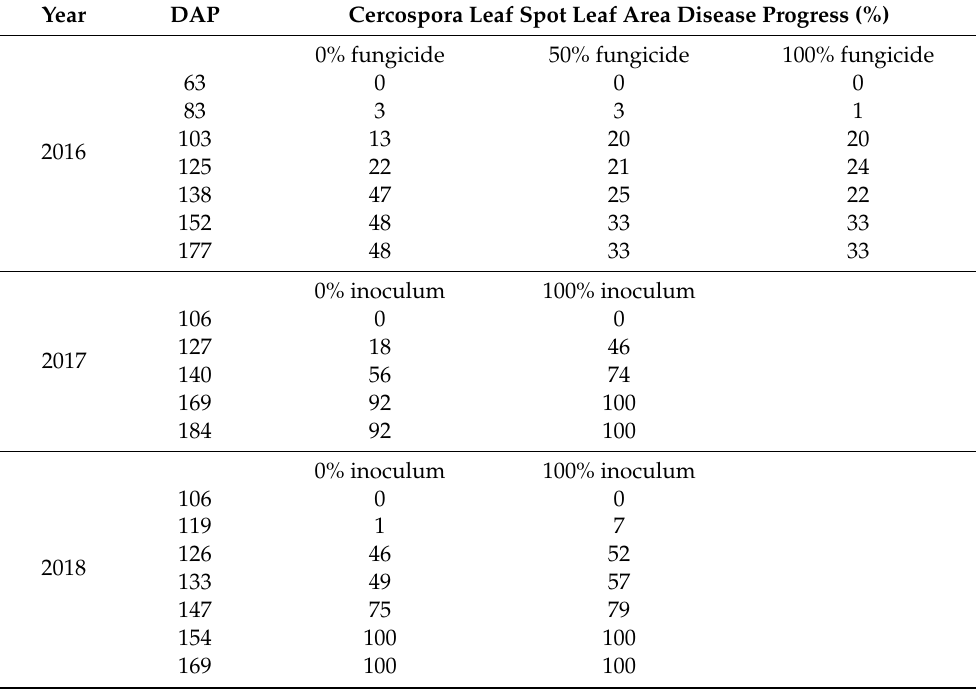
Table 1. Observed Cercospora leaf spot, as leaf area disease progress (%), on indicated days after planting (DAP) for three di ff erent fungicide treatments: 0%, 50% and 100% in which 0, 0.5, and 1 L ha − 1 of Spyrale fungicide was applied, respectively, and 0% and 100% inoculum treatments in which 0 and 1 g m − 2 of inoculum was applied,